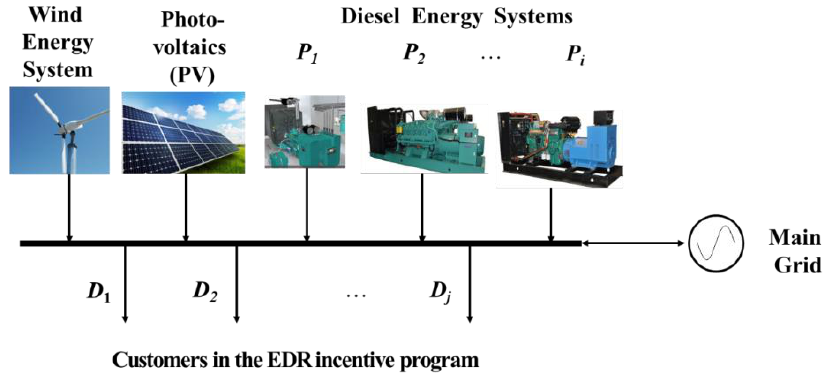
Figure 1. General outline of the case study. Table 1. Cost coefficients and operating ranges in conventional generators.